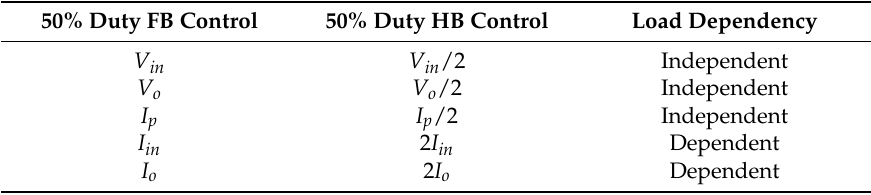
Table 2. Comparisons of voltages, currents, and their load